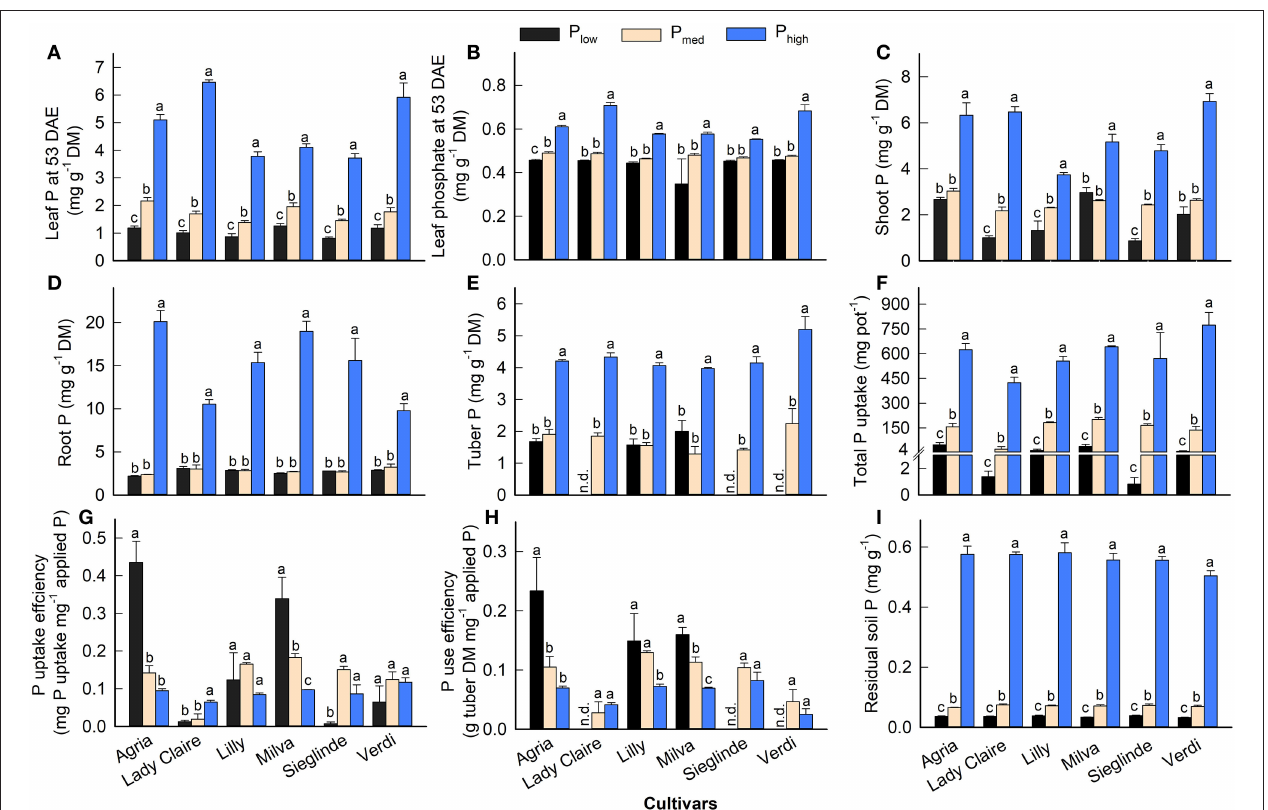
FIGURE 2 | (A–E) Phosphorus (P) concentration in different plant parts, (F) total P uptake, (G) P uptake efficiency, (H) P use efficiency, and (I) residual soil P concentration of potato cultivars with the application of P low , P med , and P high . P uptake efficiency, amount of total P uptake per unit of applied P, and P use efficiency, tuber dry matter production per unit of P uptake. Phosphate concentration (B) is expressed as mg of mineral (P) per unit of DM. Different letters in lowercase indicate a significant difference between P treatments of each cultivar by Tukey’s HSD test at p < 0.05. Error bar represents SE of means ( n = 4). DM, dry matter; n.d., not determined because of no tuber